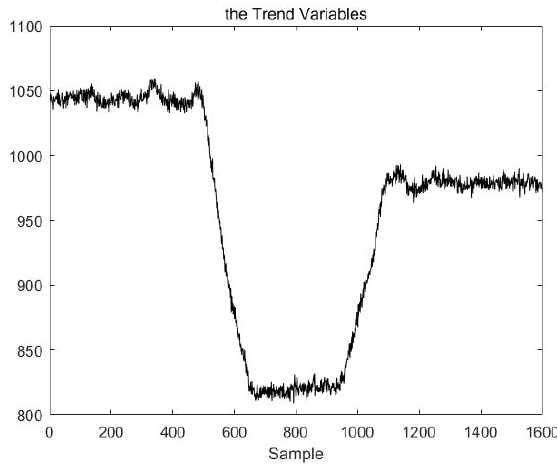
Figure 5. The change curve for this trend variable.